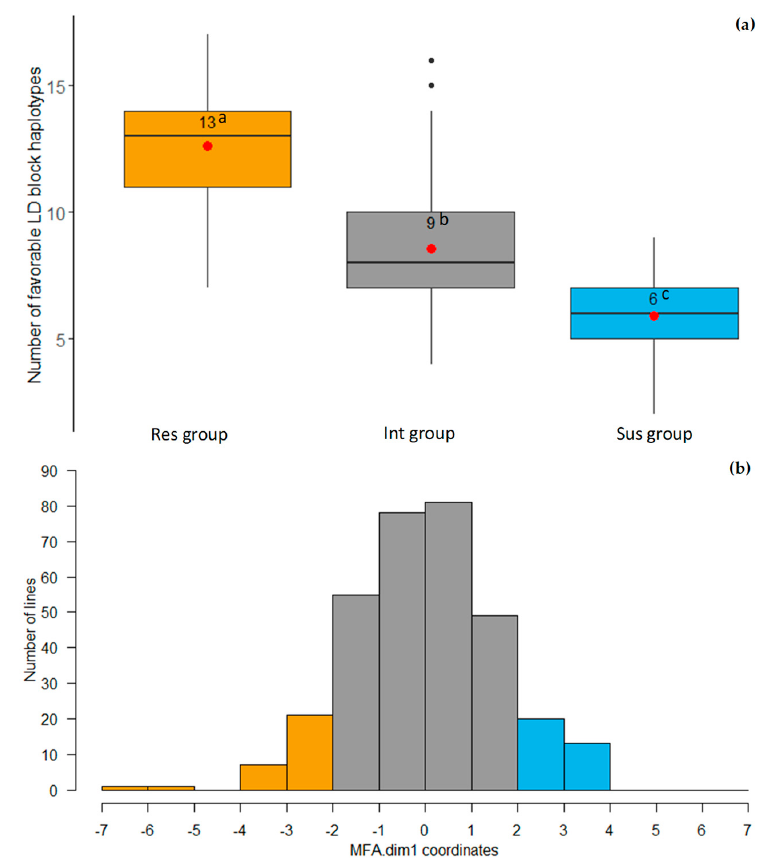
Figure 3. Comparison of numbers of favorable LD block haplotypes in resistant (Res), intermediate (Int), and susceptible (Sus) groups in the association mapping population. ( a ) A box plot of the number of favorable LD block haplotypes among three groups. The three groups were categorized by coordinates of first PC of multiple factor analysis (MFA.dim1). Numbers in the box plot indicate mean values of numbers of favorable haplotypes in the given groups. Letters represent significant di ff erences among the three groups based on the mean comparison. ( b ) Frequency distribution of MFA.dim1 in the association mapping population. Res group (MFA.dim1 < − 2, yellow color) carried the highest number of favorable haplotypes, Int group ( − 2 < MFA.dim1 < 2, gray color) had an intermediate number of favorable haplotypes, and Sus group (MFA.dim1 > 2, blue color) carried the lowest number of favorable haplotypes.